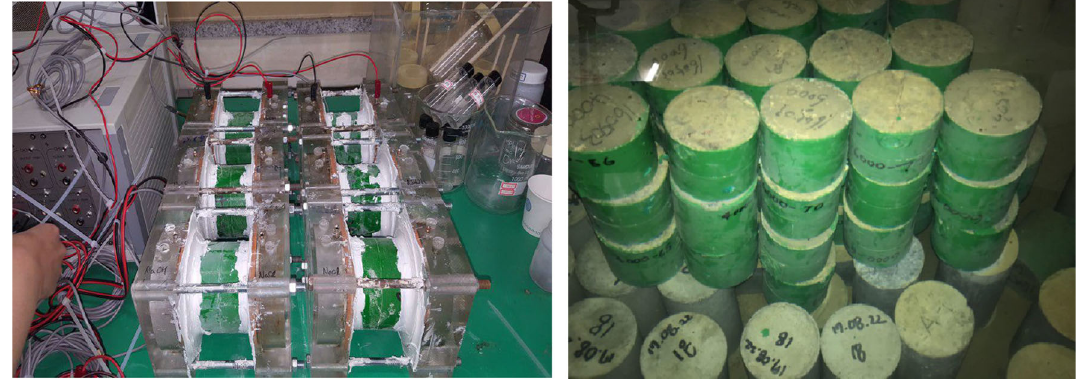
Fig. 2 Photographs of accelerated diffusion test setup and concrete samples under curing.